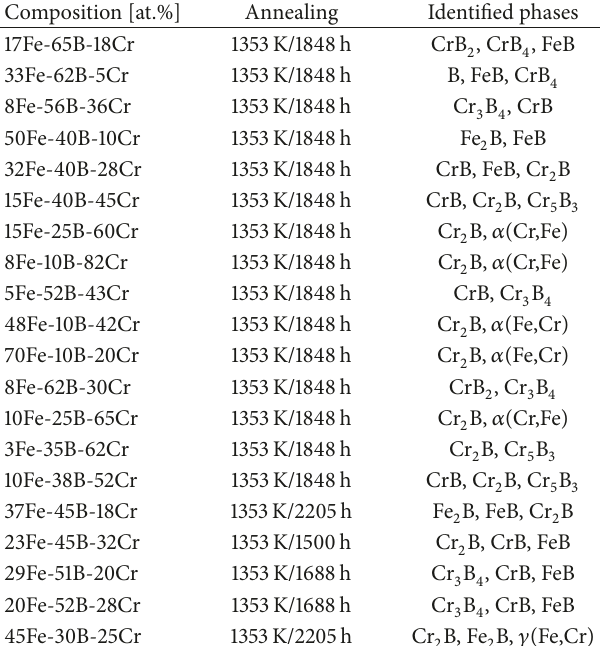
Table 1: Chemical compositions of model alloys, conditions of annealing, and phases identified in the alloys after annealing. Composition [at.%]